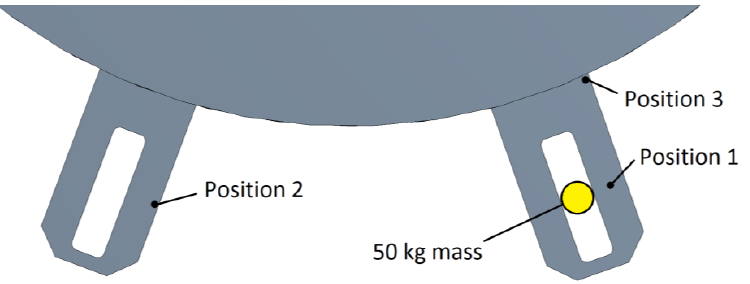
Figure 4. Positions of the dial gauges and of the applied mass.